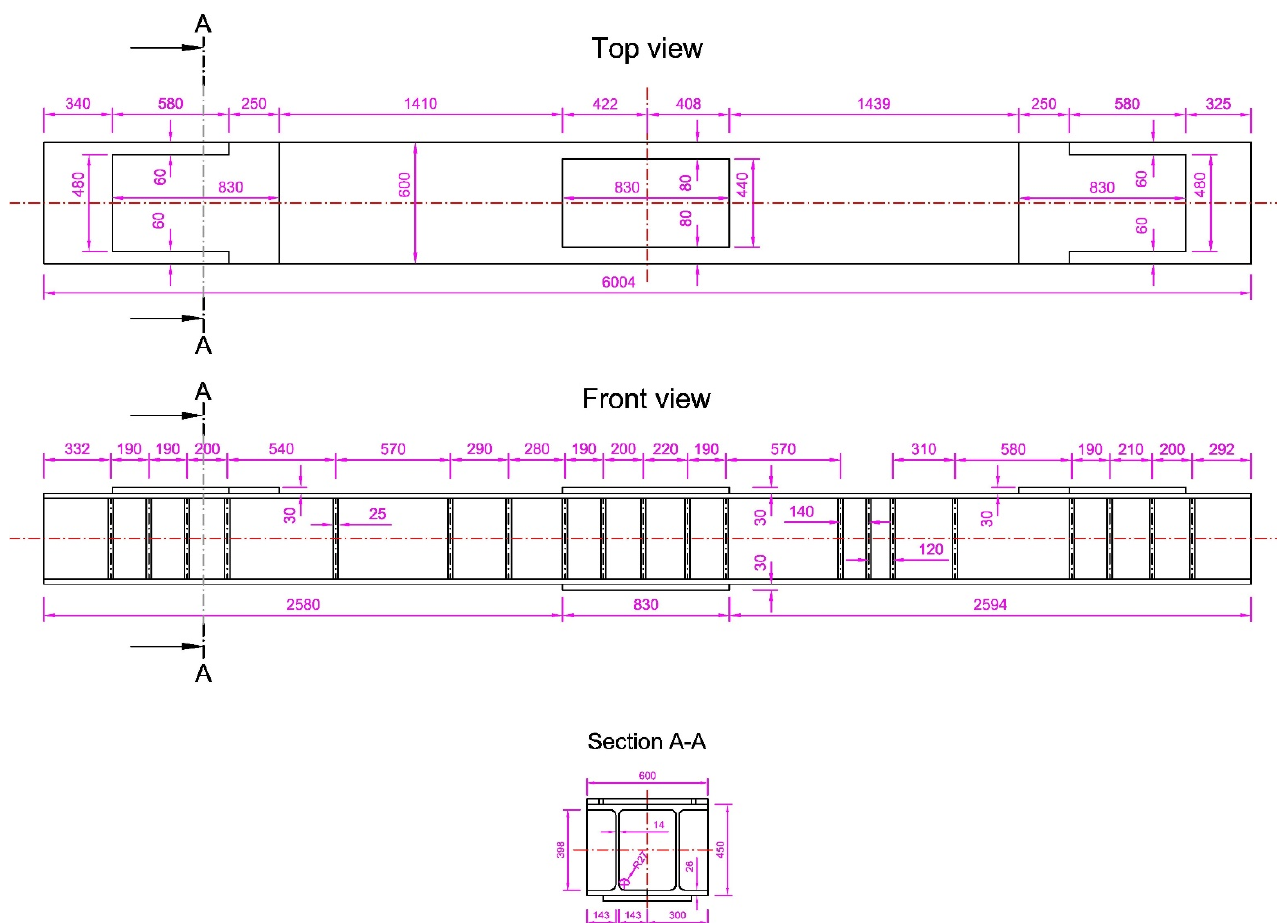
Figure 10. Bending of the beam during the SLT on the basis of vertical displacement in control points numbers 5–9 from Trimble S3: ( a ) first loading cycle and ( b ) second loading cycle. On the basis of the point cloud from laser scanning, the detailed beam geometry data was obtained, which are shown in Figure 11.